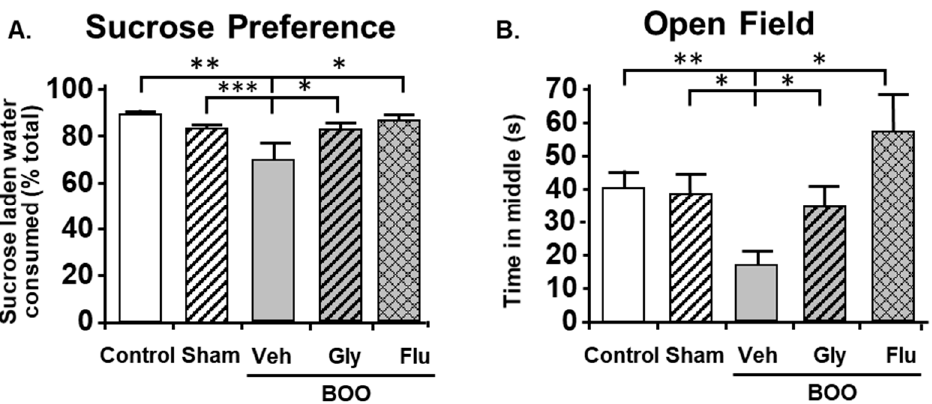
Figure 5. After 12 weeks of BOO, rats show signs of depression. These behavior differences were not present when rats were given glyburide or fluoxetine (Flu), an anti-depressant. ( A ). The sucrose preference assay (a measure of anhedonia). The assay was performed as described in the Materials and Methods section. The results are presented as the amount of sucrose laden water consumed as a percentage of the total volume imbibed. Veh = vehicle ‐ treated, Gly = glyburide ‐ treated. Results are the mean ± 95% confidence intervals; * p < 0.05, ** p < 0.01 and *** p < 0.005 by ANOVA and Dunn’s test. ( n = 24, 24, 14, 14, 6). This figured was reprinted, with permission from the Wiley Periodicals, from [9]. ( B ). The open field assay (a measure of anxiety.) The assay was performed as described in the Materials and Methods section and scored by a blinded investigator. The results are presented as the time in which at least 2 paws were present in the middle section of the open field during the 10 min test session. Veh = vehicle ‐ treated, Gly = glyburide ‐ treated. Results are the mean ± 95% confidence intervals; * p < 0.05 and ** p < 0.01 by ANOVA and Dunn’s test. ( n = 26, 23, 15, 13, 6).